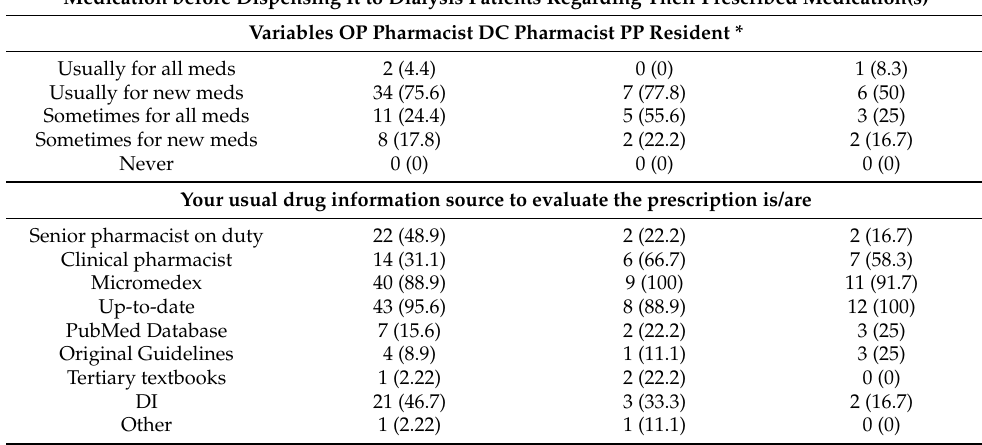
Table 2. Practices of pharmacists towards drug information